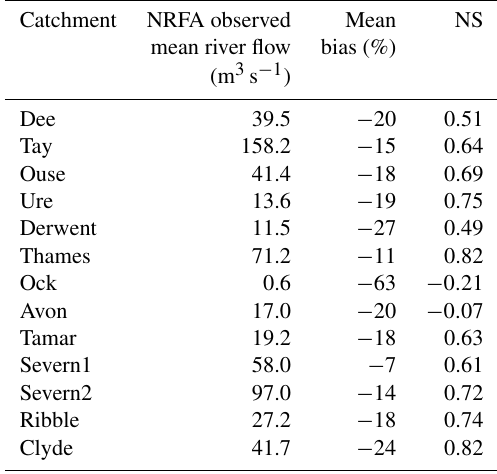
Table 2. Mean observed river flow at the 13 selected catchments in Great Britain and performance metrics for JULES using the PDM parameters detailed in Sect. 3.4 (fixed b = 20 and grid-cell slope- dependent S 0 /S max